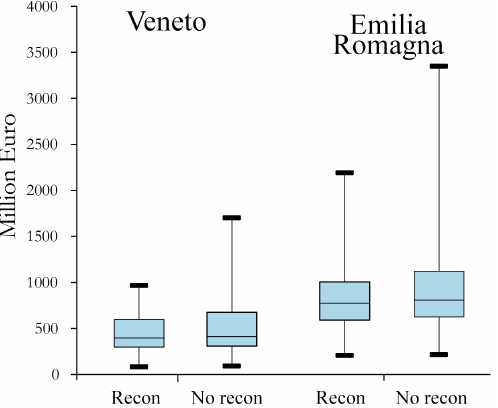
Figure 5. Comparison of losses with and without reconstruction demand for the two flood